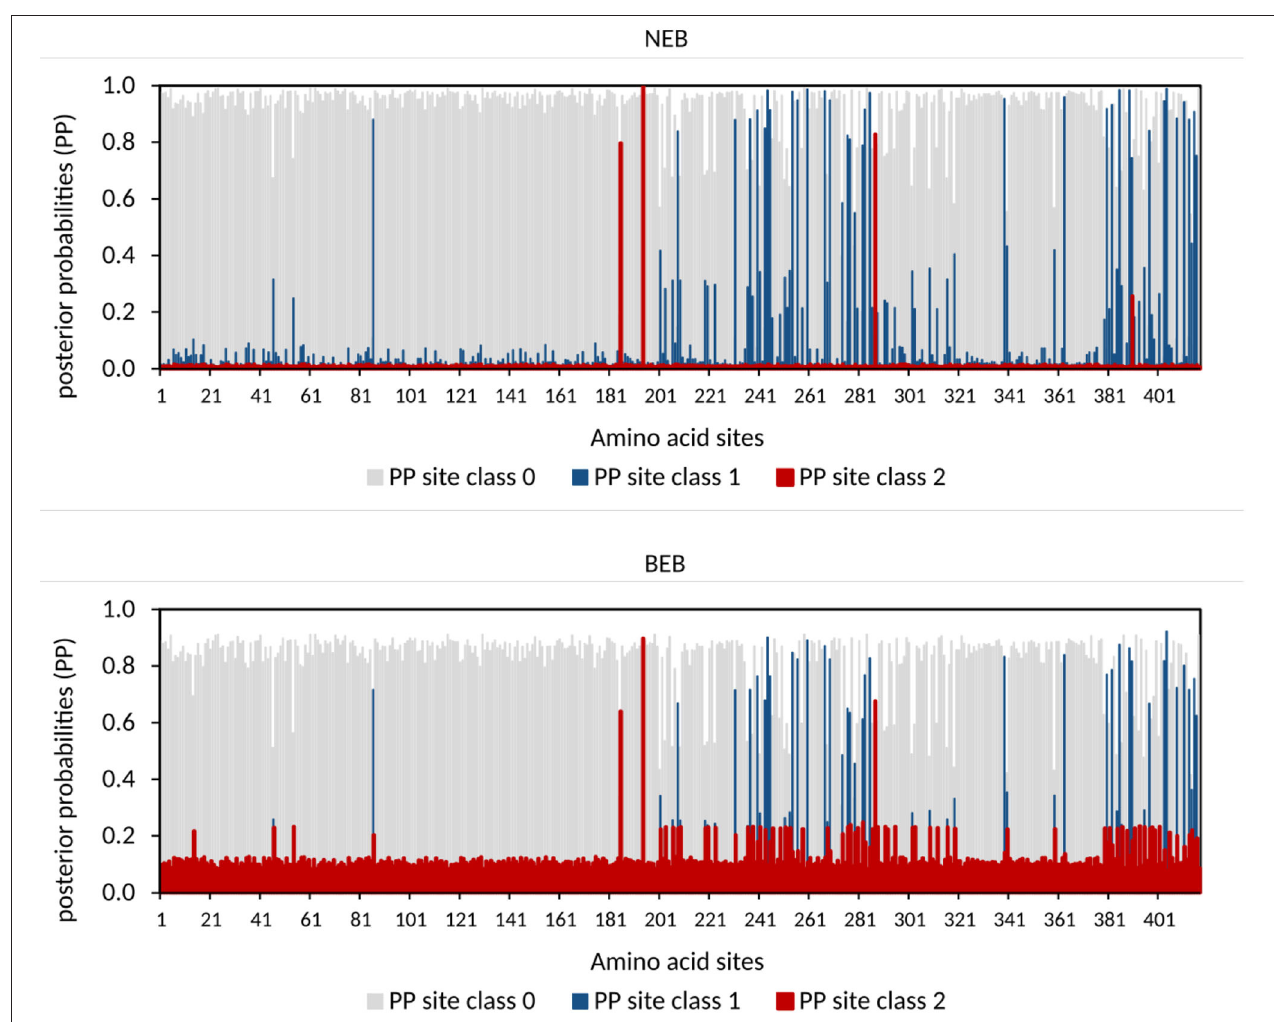
FIGURE 3 | Quantitative representation of the Naive Empirical Bayesian (NEB) and Bayes Emperical Bayesian (BEB) class probabilities derived from the branch-site model comparison as a test for positive selection. The amino acid sites respective to human SIRT1 protein sequence fit into the classes with certain dN/dS ratios with the given posterior probabilities. Posterior probabilities for site class 2 indicate the probability for positive selection and are shown in